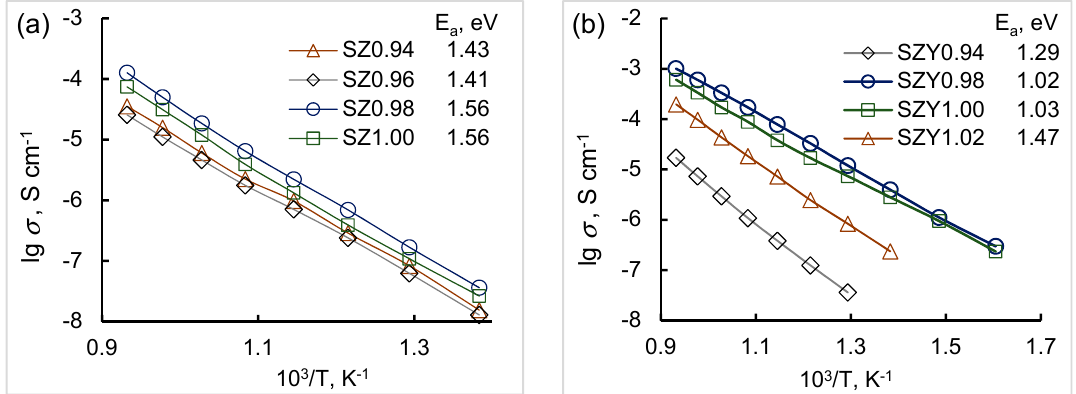
Figure 6. Arrhenius plots of the total conductivities of SZx ( a ) and SZYx ( b ) in air (pH 2 O = 40 Pa). The lines between points are only a guide to the eye.